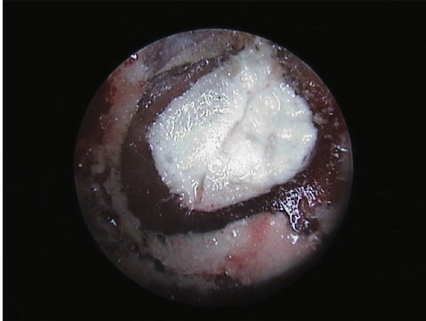
Figure 14: Endoscopic view of 1.1 after fi lling of the retrograde cavity with MTA.